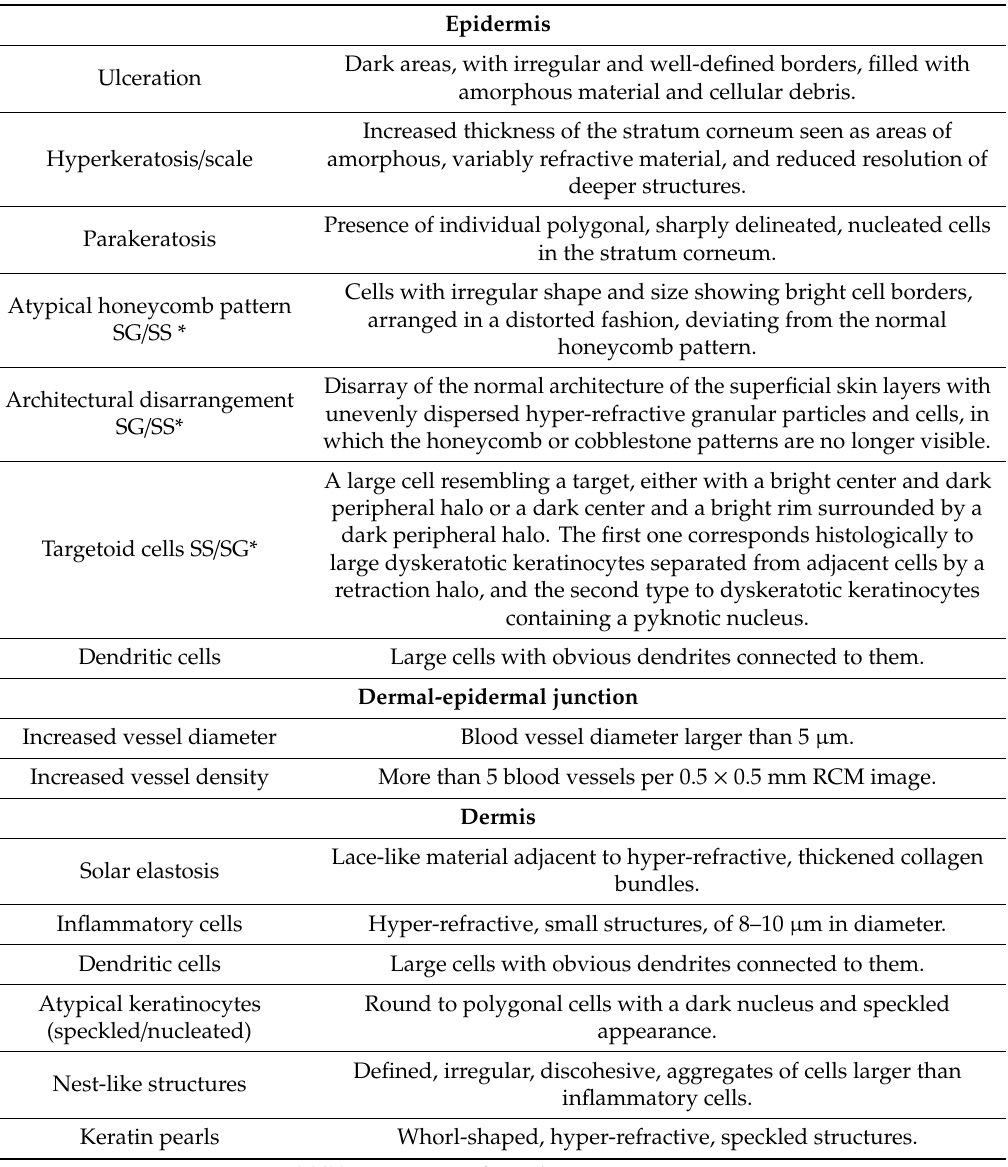
Table 1. Reflectance confocal microscopy (RCM) criteria for the diagnosis of actinic cheilitis (AC) and lip squamous cell carcinoma